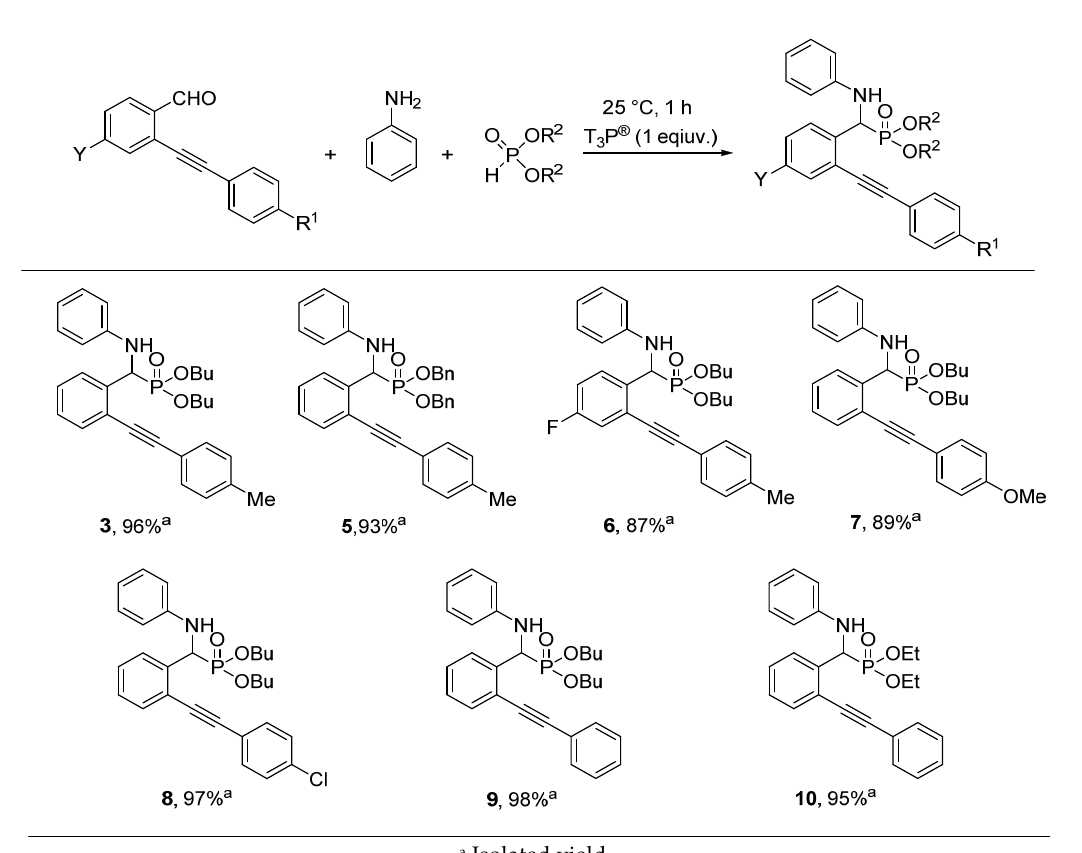
Figure 2. T 3 P ® -mediated condensation of 2-alkynylbenzaldehydes, aniline and dialkyl phosphites.